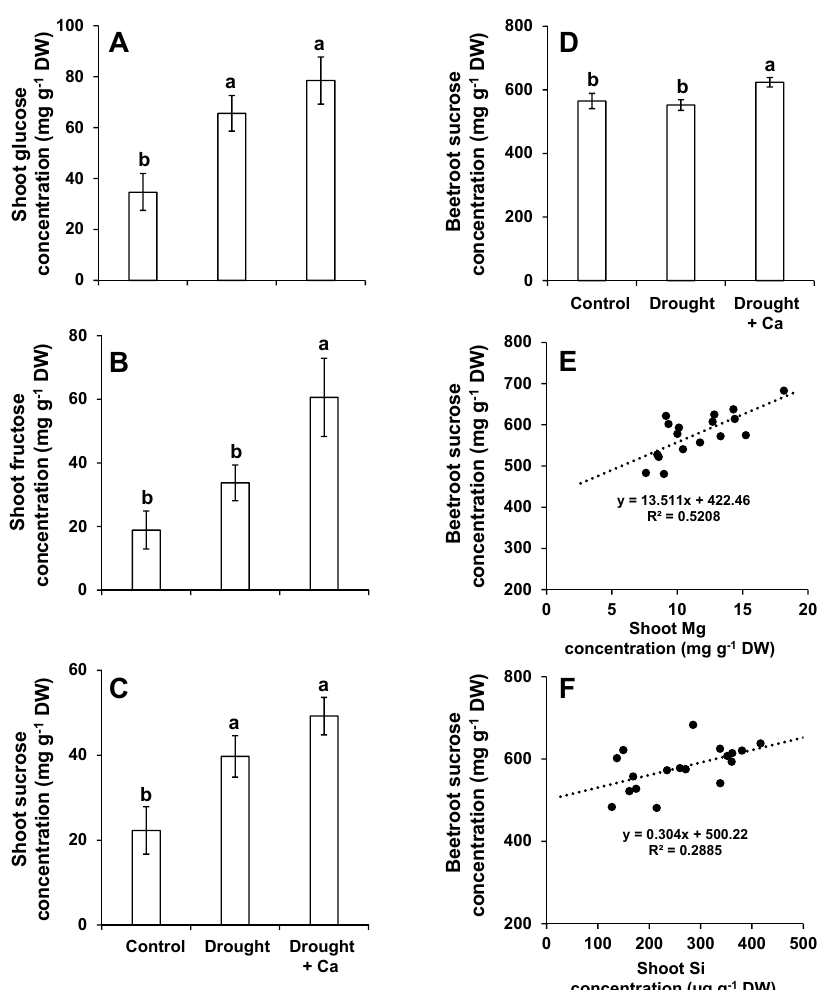
Figure 3. Influence of foliar application of Ca 2 + on soluble sugar concentration in sugar beet exposed to drought stress. ( A ) Shoot glucose concentration; ( B ) shoot fructose concentration; ( C ) shoot sucrose concentration; ( D ) beetroot sucrose concentration; ( E ) correlation between beetroot sucrose content and shoot Mg content; and ( F ) correlation between beetroot sucrose content and shoot Si content. Plants were grown in pots for a duration of 8 weeks. Five-week-old sugar beet plants were kept at 90% field capacity as control or exposed to drought stress (30% field capacity) for a duration of 3 weeks. Ca 2+ was applied at BBCH14 and BBCH18 in concentration of 5 L ha − 1 corresponding to 540 g Ca ha − 1 . Leaves and beetroot were harvested at 60 days after sowing for soluble sugars analysis. Bars indicate means ± SEM. Different letters denote significant differences according to ANOVA followed by SNK test ( p < 0.05; n = 6).